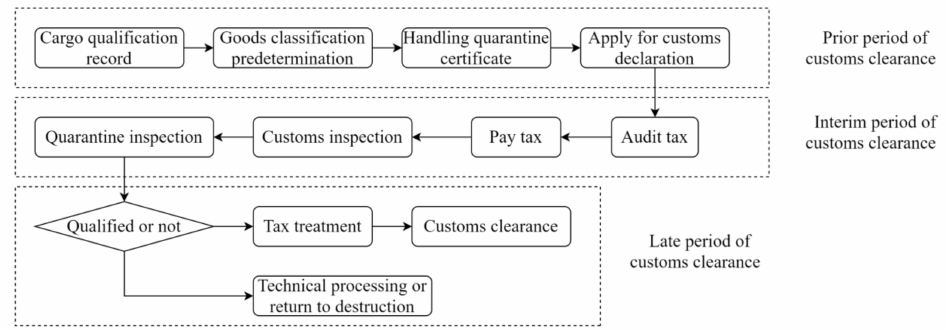
Figure 3. Flow chart of customs clearance process.